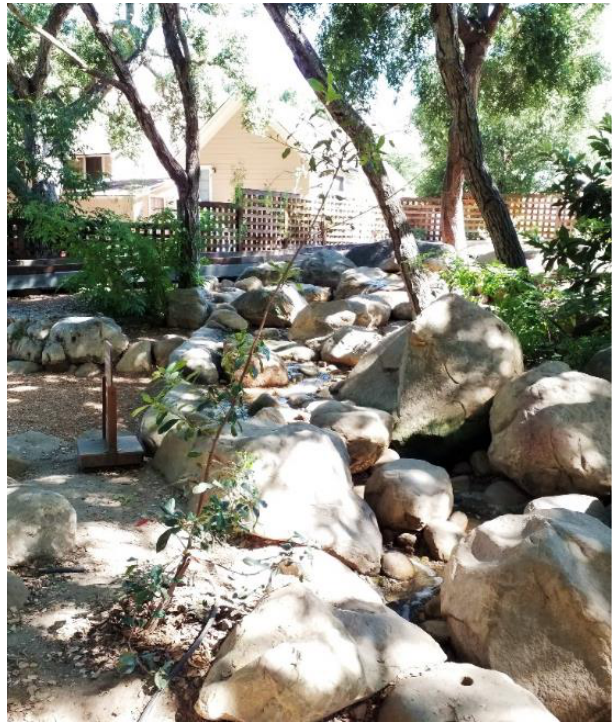
Figure 4. Upper creek area.